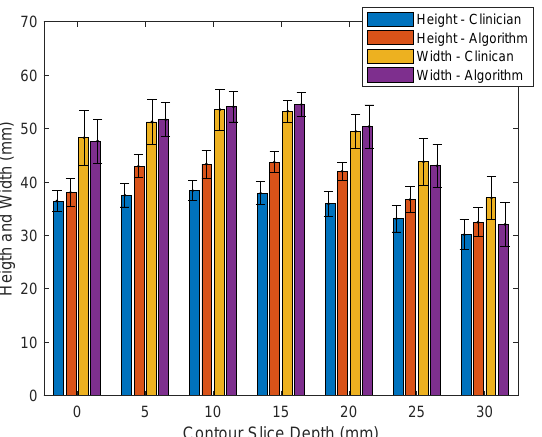
Figure 12. Bounding box, indicated in red, and shaded-blue polygon contour area used for prostate contour height, width, and volume measurements.